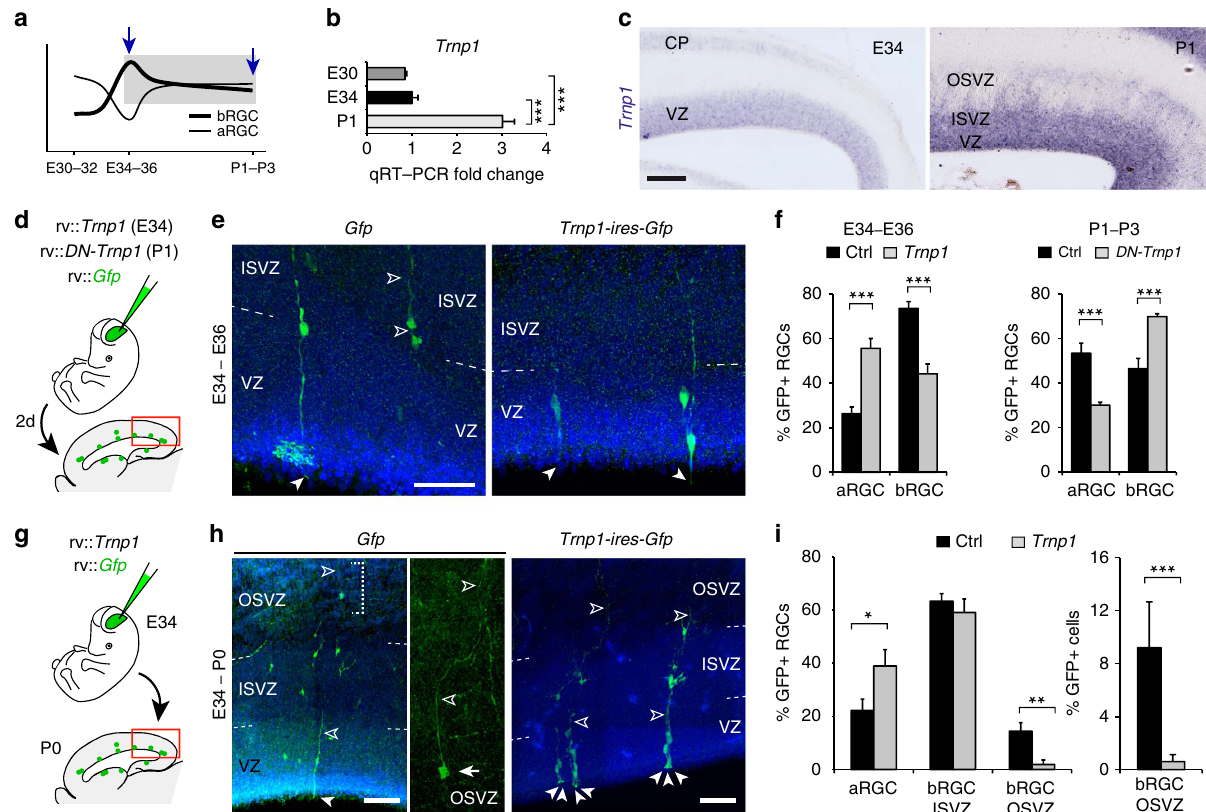
Figure 7 | Closure of the restricted period for bRGC production and OSVZ generation depends on developmental variations of Trnp1 expression. ( a – c ) Validation by qRT–PCR and ISH of differential expression of Trnp1 between E34 and P1 (later period of bRGC generation from aRGC; mean values þ s.e.m., *** P o 0.001, unpaired t -test). ( d – f ) Overexpression of Trnp1 by retroviral delivery from E34 to E36 decreased bRGC production and increased aRGC abundance, whereas expression of dominant-negative (DN) Trnp1 from P1 to P3 had the opposite effect (mean values þ s.e.m., *** P o 0.001, w 2 -test). ( g – i ) Sustained overexpression of Trnp1 from E34 to P0 by retroviral delivery markedly blocked bRGC production for the OSVZ. Measures are relative to GFP þ RGCs, or all GFP þ cells in lineage (mean values þ s.e.m., * P o 0.05, ** P o 0.01, *** P o 0.001, w 2 -test). In all panels, solid arrowheads indicate apical end feet of aRGCs and open arrowheads indicate basal fibres of bRGCs. Scale bar, 150 m m ( c ); 75 m m ( e , h